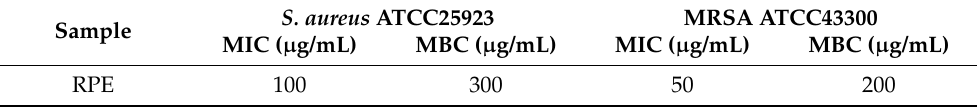
Table 2. Antibacterial activity of RPE in terms of MIC and MBC against S. aureus and MRSA. Sample